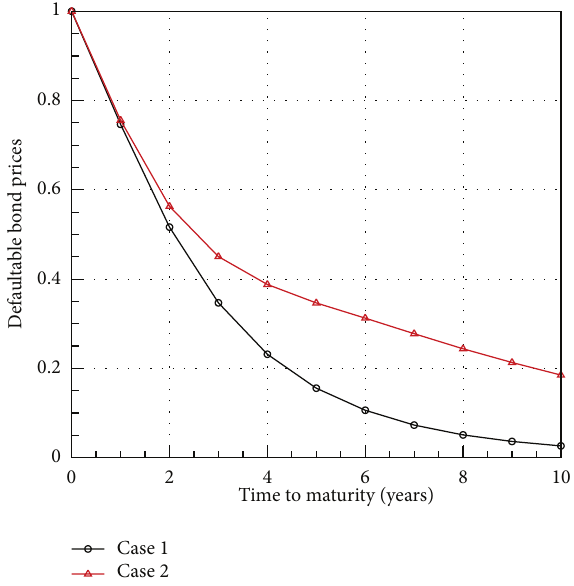
Figure 1: Defaultable bond prices (source: KIS Pricing).